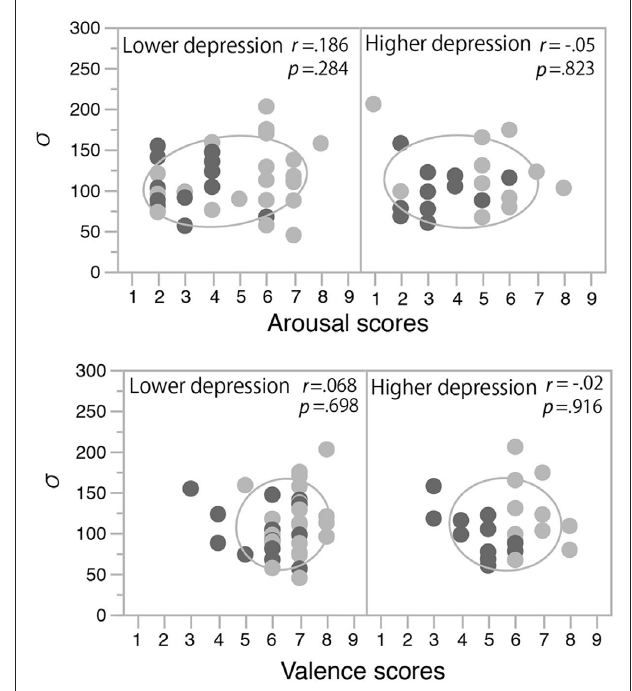
FIGURE 6 | Correlations between mood rating scores and σ values in Experiment 2. Light and dark gray plots indicate happy and non-happy conditions, respectively. Ellipses show a probability ellipse of